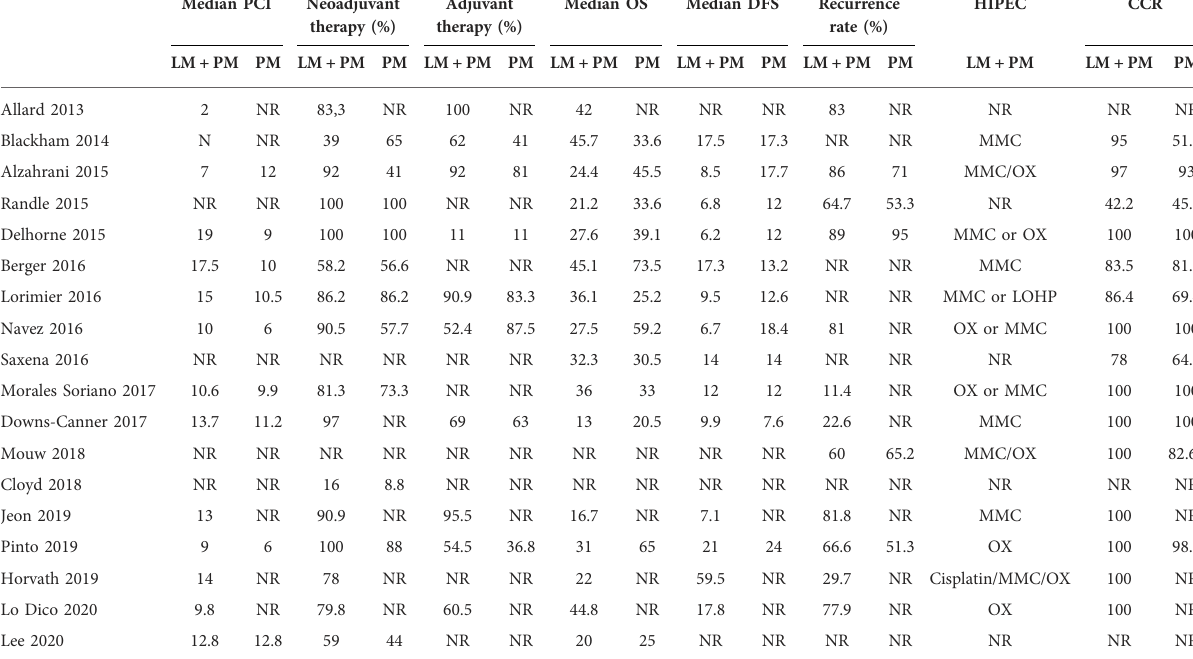
TABLE 2 Survival data and follow-up.